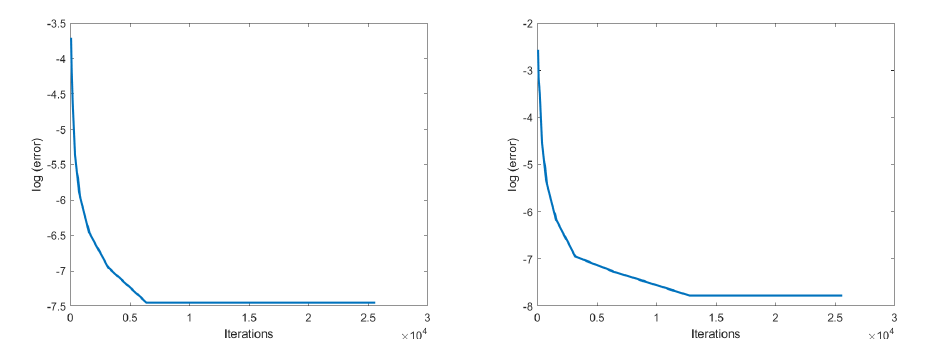
Figure 6. Error value (represented in log scale) obtained for different iterations with the variance normalization method ( top ) and using the optimal loss weight ( bottom ). The reference solution has been obtained solving the PDE by the finite element method.